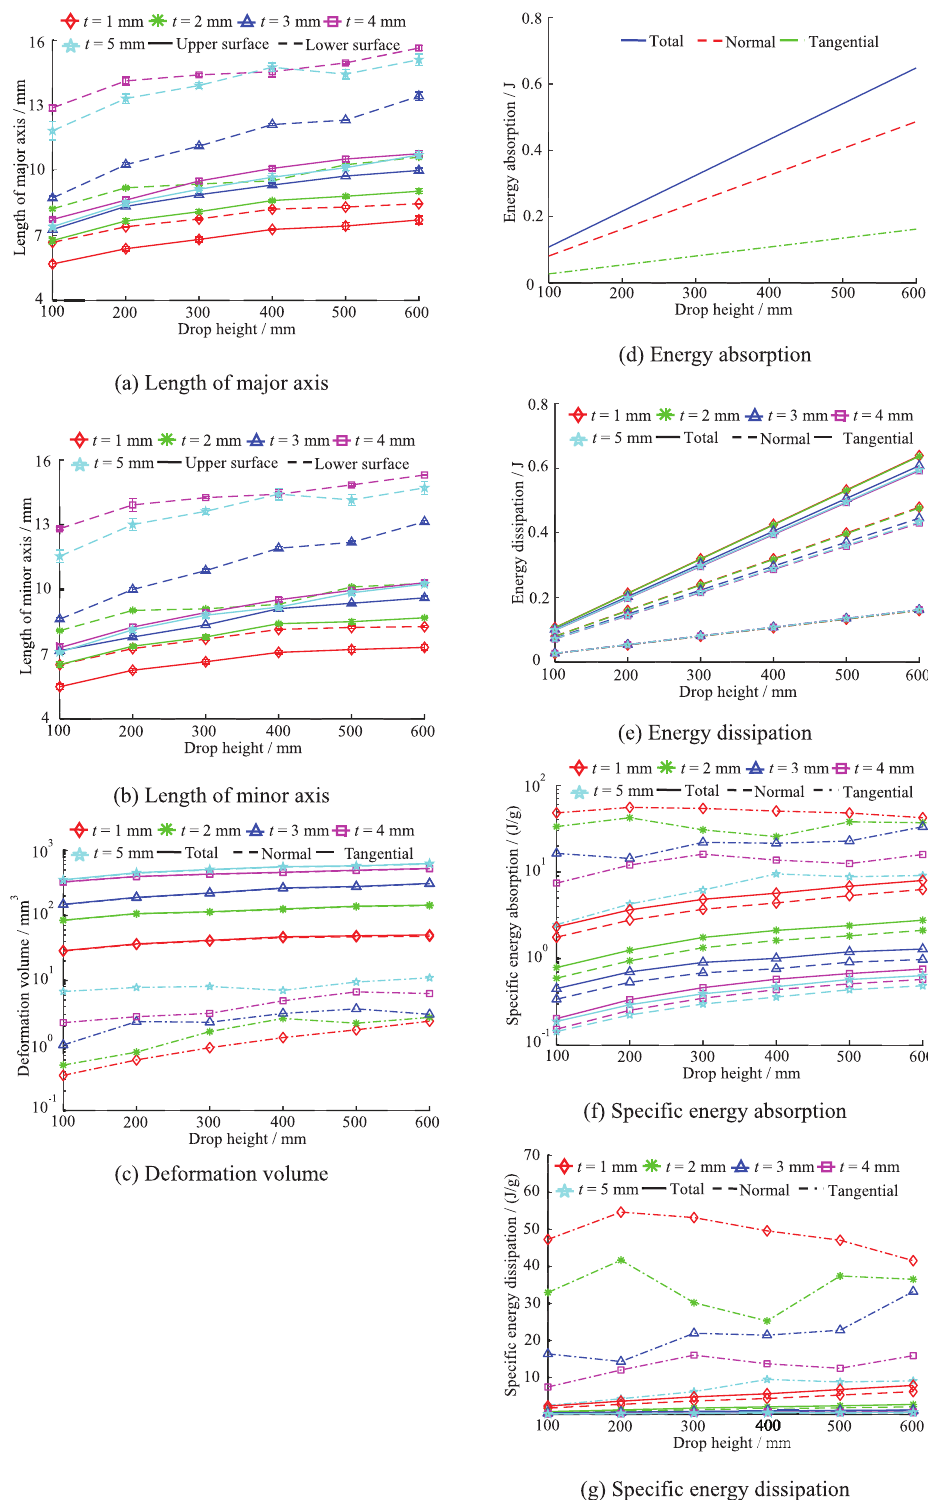
Fig. 4. Geometrical characteristic sizes of contact surface, deformation volume and speci fi c energy parameters at different drop